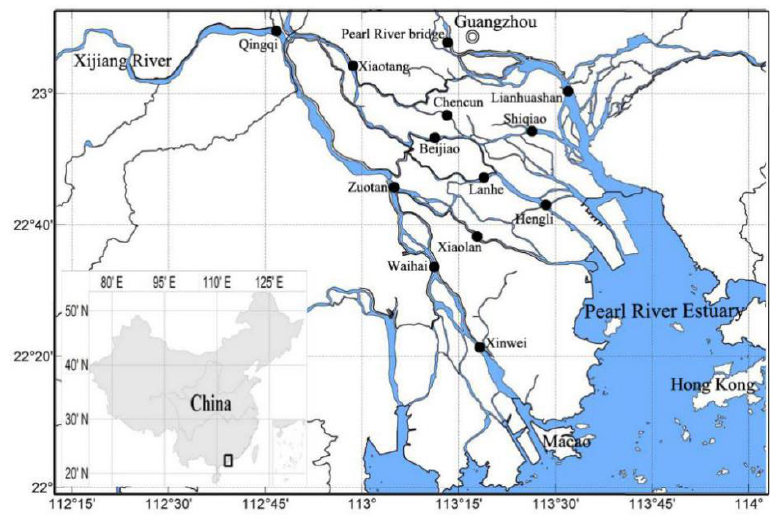
Figure 1. Location of the different sampling sites in the Pearl River Delta. The map was produced using ArcGIS software (Version 10.5, Redlands, CA, USA). Note: QQ, Qingqi; PRB, Pearl River Bridge; XT, Xiaotang; LHS, Lianhuashan; CC, Chencun; SQ, Shiqiao; BJ, Beijiao; ZT, Zuotan; LH, Lanhe; HL, Hengli; XL, Xiaolan; WH, Waihai; XW, Xinwei. An inset map shows the location of the study area within China.